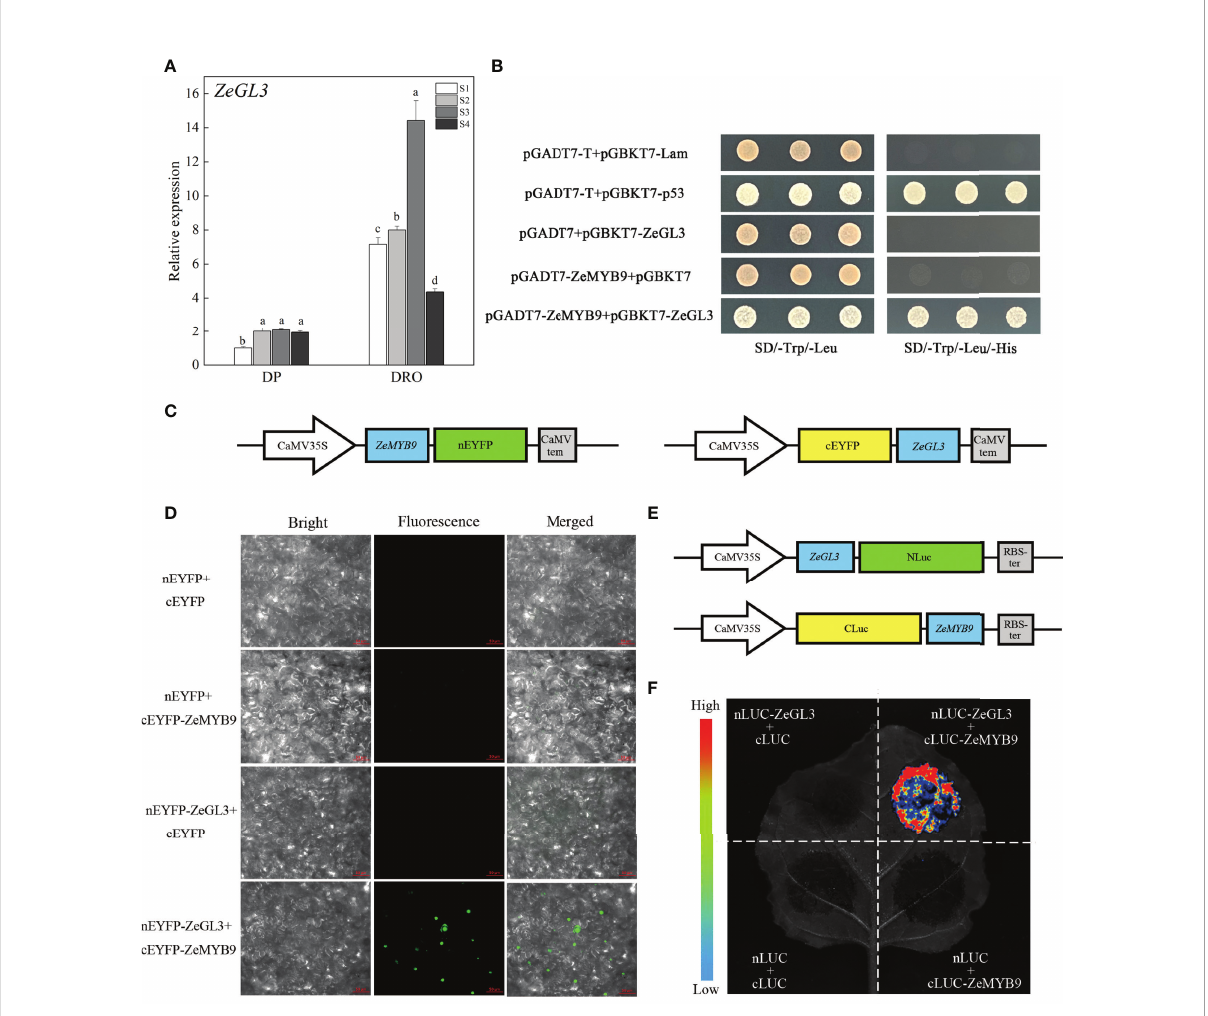
FIGURE 5 Expression analysis of ZeGL3 and interaction analysis of ZeMYB9 and ZeGL3. (A) Relative expression levels of ZeGL3 in the petals of DP and DRO at different developmental stages. ZeACT gene was used as an internal control for normalization, and three biological replicates were performed. Error bars indicate standard error (SE), and different lowercases indicate signi fi cant differences (P < 0.05). (B) Yeast two-hybrid assay for interaction relationship analysis between ZeMYB9 and ZeGL3. (C) Reporter plasmids construction diagrams for Bimolecular fl uorescence complementation (BiFC) assays. (D) BiFC analysis between ZeMYB9 and ZeGL3 in N. benthamiana leaves. (E) Reporter plasmids construction diagrams for luciferase complementary assay (LCA). (F) ZeMYB9 could interact with ZeGL3 in